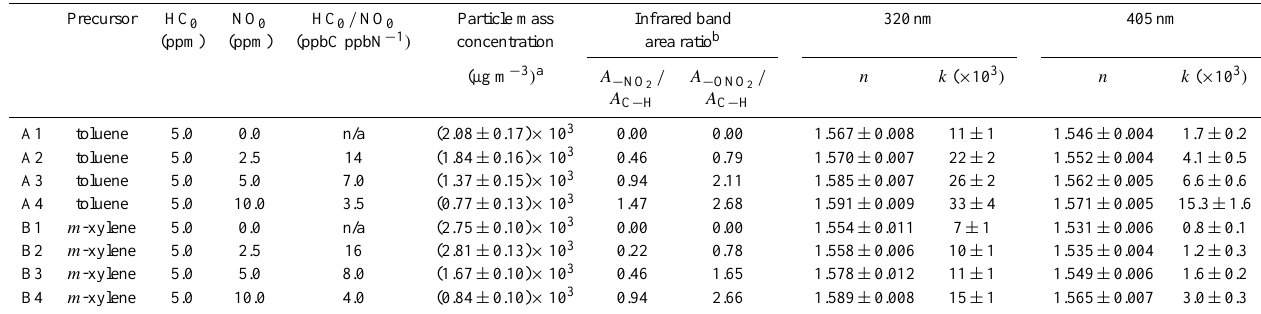
Table 1. Experimental conditions, infrared band areas of organonitrogen groups normalized by the area of alkane bands, and complex refractive indices of the studied SOMs.